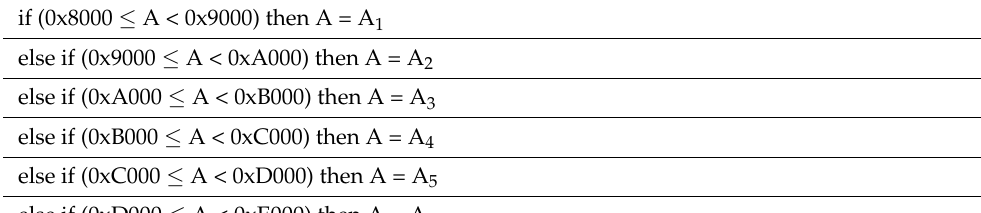
Table 8. MPS and LPS interval subdivision quantization level in case of 8-level.